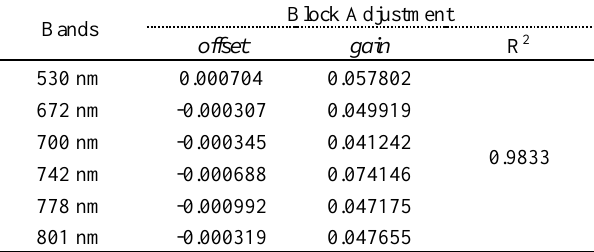
Table 1. Radiometric calibration coefficients of the